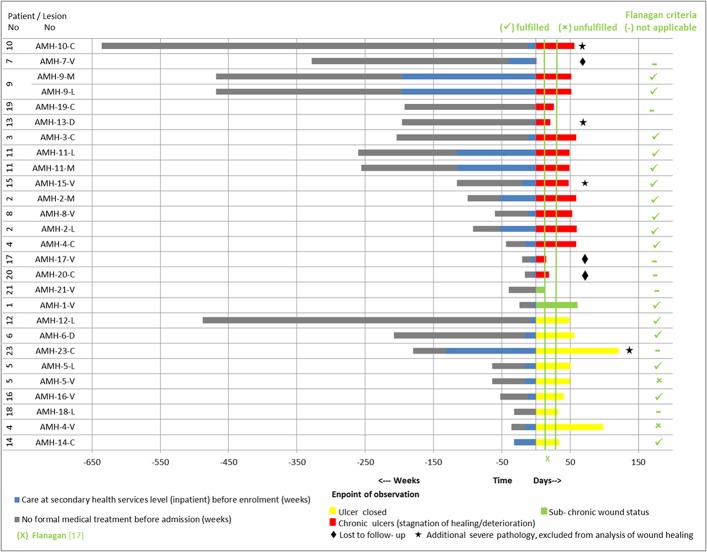
Pre-enrolment history and post-enrolment observation of IS2404 PCR positive ulcers of the study patients at the SHC center (the patient code “AMH” refers to the patient numbering at the secondary health care center in Amasaman).